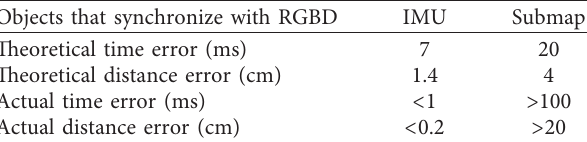
Table 1: Errors occurred in time